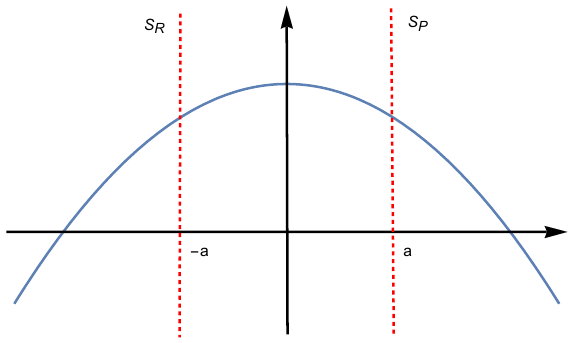
Figure 2 . Schematic plot of barrier crossing model of black hole phase transition with non- Markovian